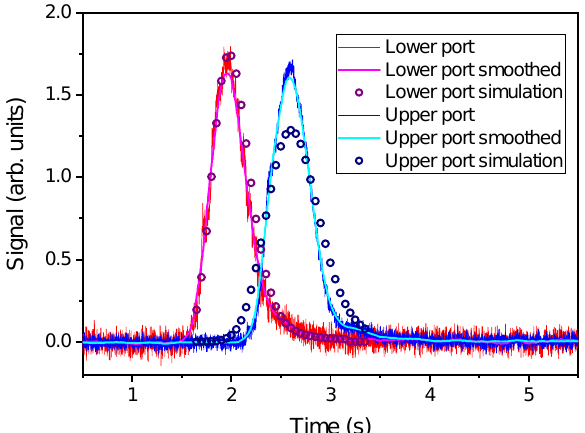
Figure 11. Comparison between simulation and experimental data for concentration profiles at the average velocity 6 m/s, T = 105 ◦ C).